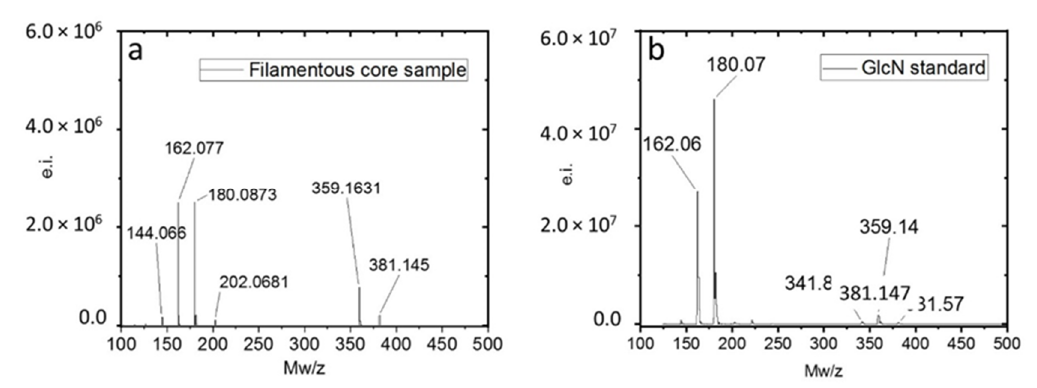
Spectra of electrospray-ionization mass spectroscopy (ESI-MS). ( a ) Demineralized filamentous core of sample Jal 11 after hydrolysis with 6M HCl. ( b ) Commercial d-glucosamine (dGlcN) standard as a positive control.